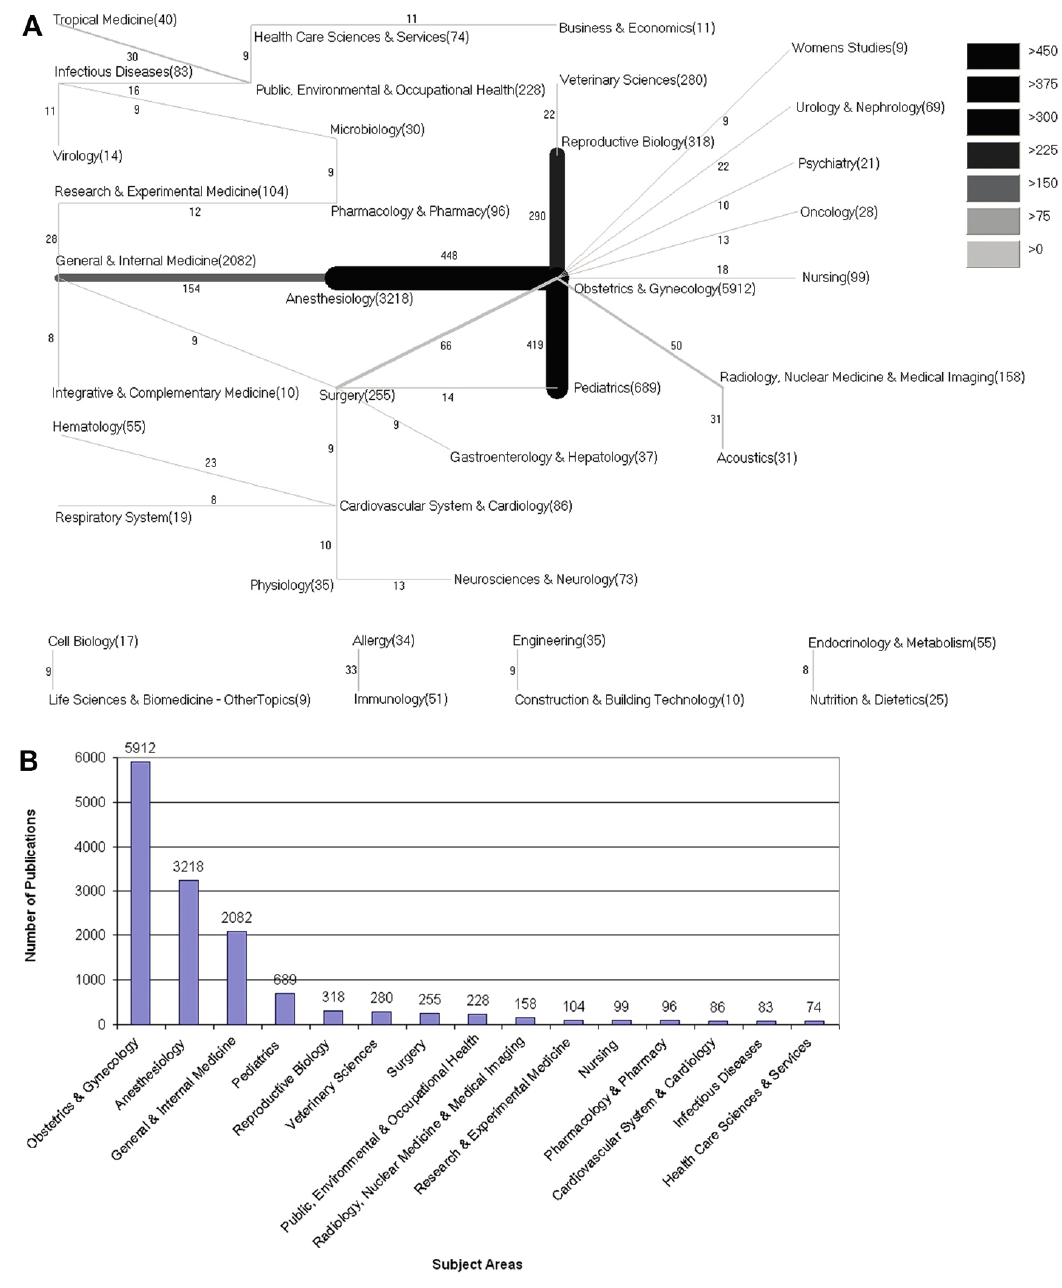
Figure 5. Subject areas. ( A ) Combination of the most assigned subject areas ( B ) Number of publications regarding the most assigned subject